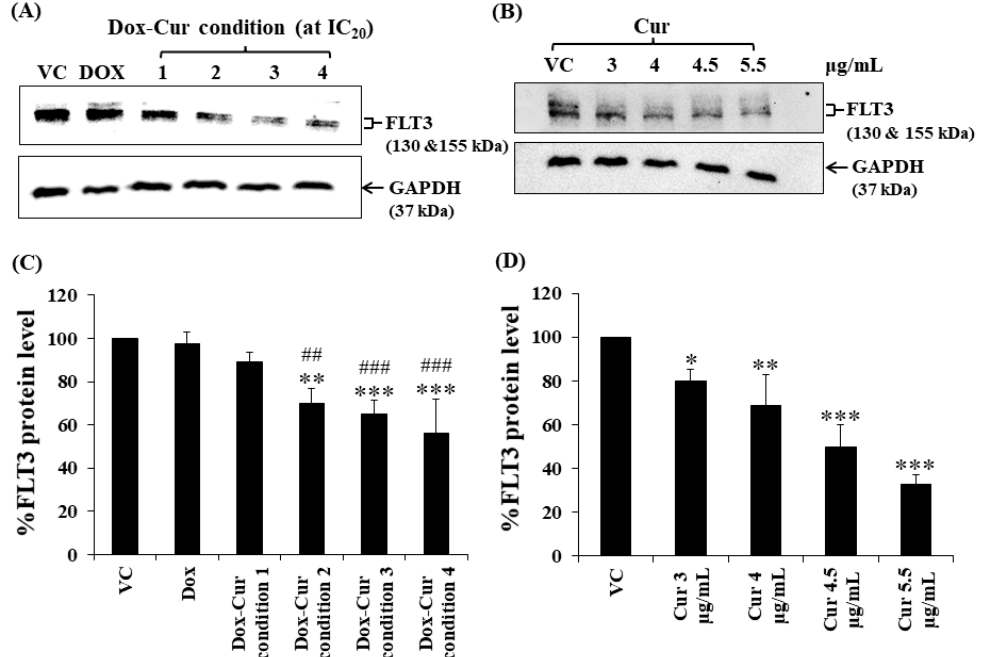
Figure 4. FLT3 protein expression of EoL-1 cells after treatment with Dox and combined treatment of Dox–Cur at concentra- tion value of IC 20 for 48 h. Protein bands ( A ) and percentage ( C ) of FLT3 protein expression level of EoL-1 cells treated with DMSO (VC), Dox at concentration of 6 ng/mL, Dox–Cur condition 1 (3 ng/mL Dox + 3 µ g/mL Cur), Dox–Cur condition